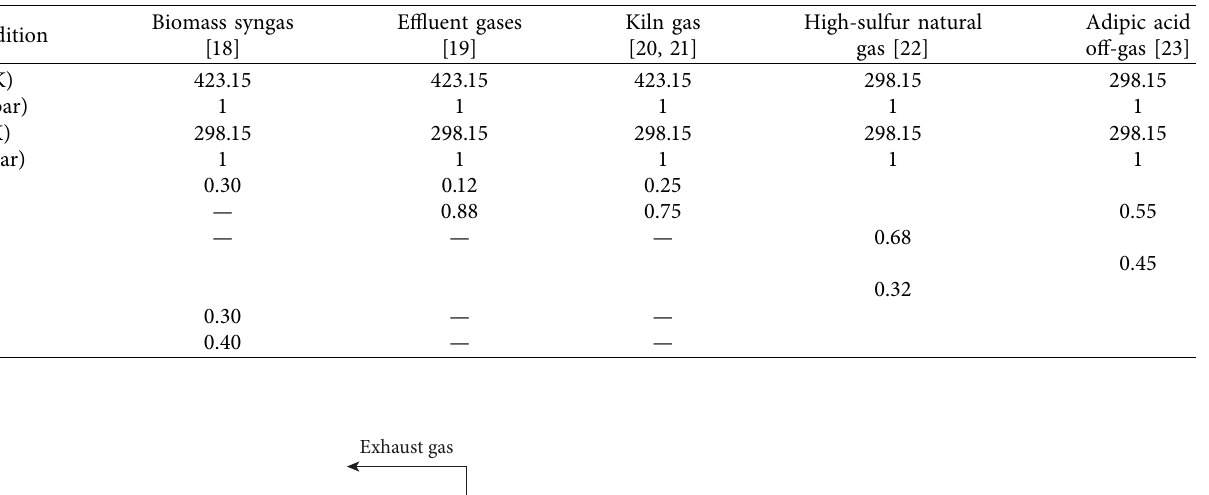
Table 1: Te typical condition of gas streams.